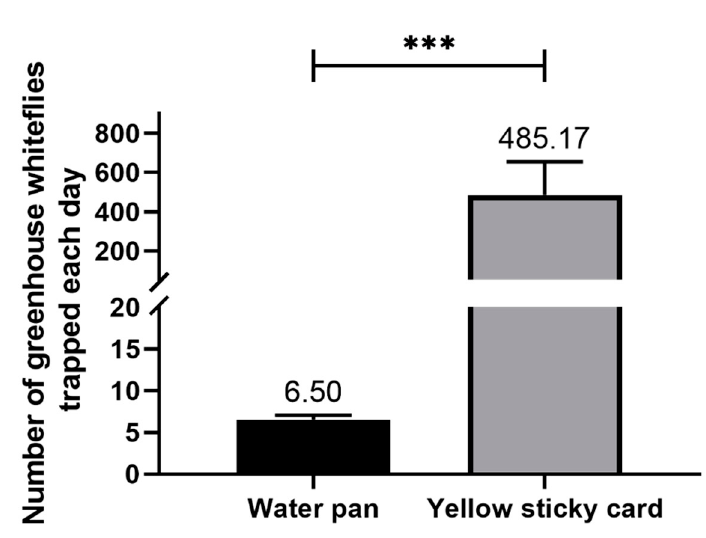
Figure 3. Number of T. vaporariorum trapped by the water pan or yellow sticky card in one LED trap. *** , Significant difference at p < 0.001 by the pairwise t test for the total number of captures. Error bars represent the standard error.